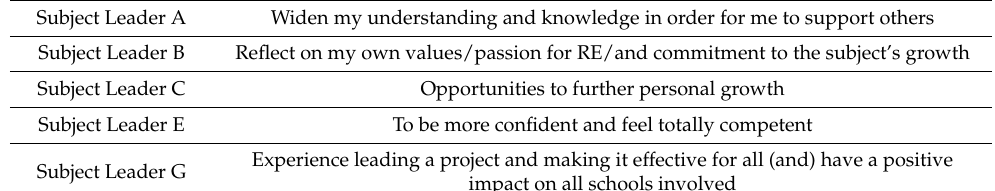
Table 3. Personal development: aligned with collaboration and reflection.